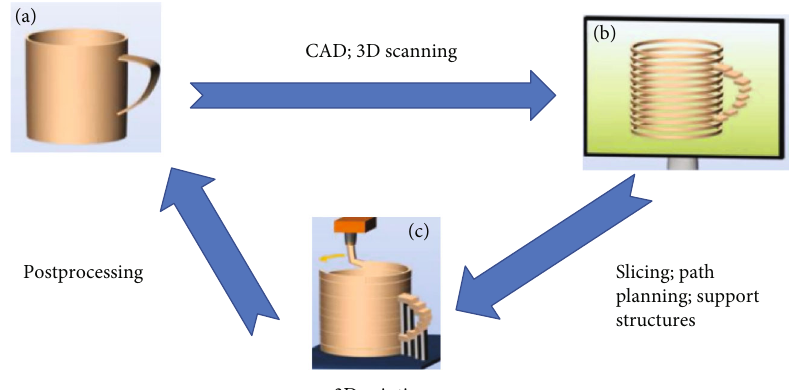
Figure 1: Summary of an additive manufacturing process [2].